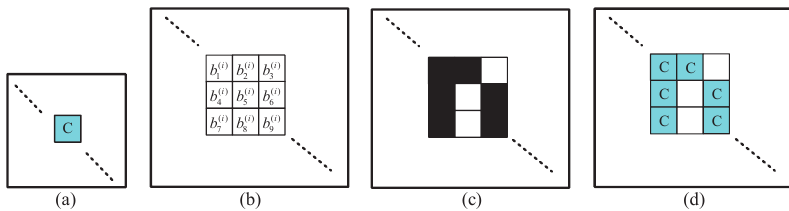
Figure 5. Block patterns: ( a ) a pixel with a color in CCI ( b ) the corresponding block B ( i ) in NS i ( c ) the corresponding 6 B 3 W block in NS i ( d ) the corresponding block in CS i